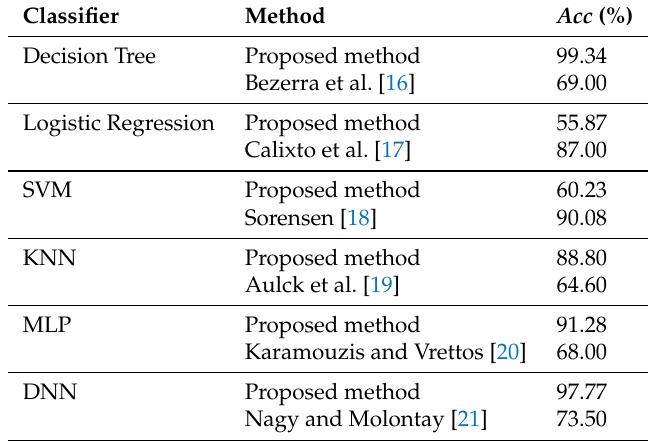
Table 8. Comparison of classifiers with recent methods using different datasets and accuracy ( Acc ) as an evaluation